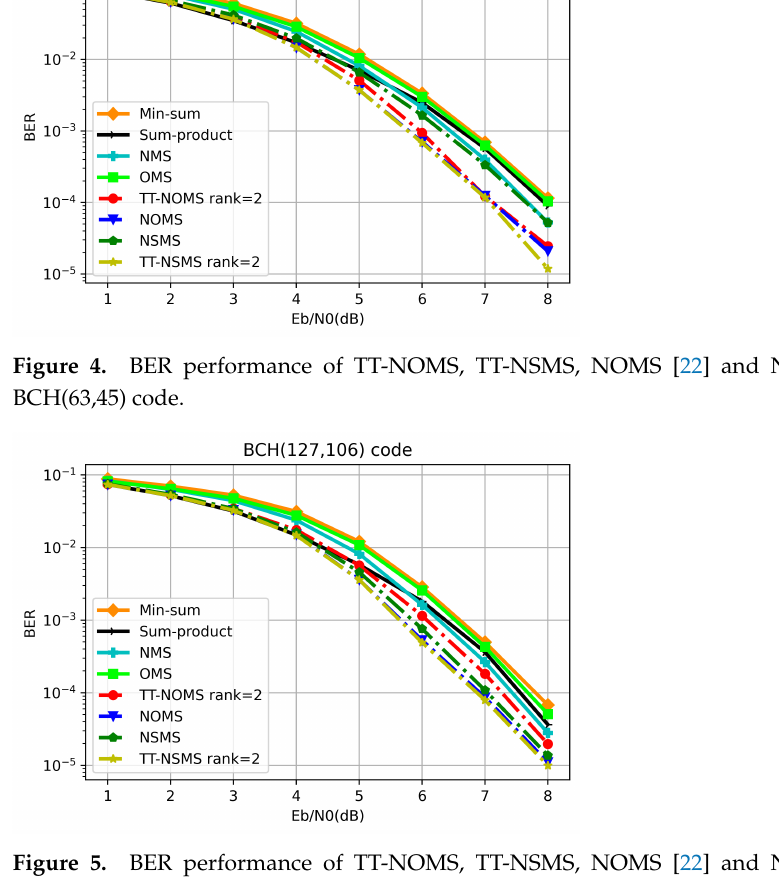
Figure 5. BER performance of TT-NOMS, TT-NSMS, NOMS [22] and NSMS algorithms for BCH(127,106) code.